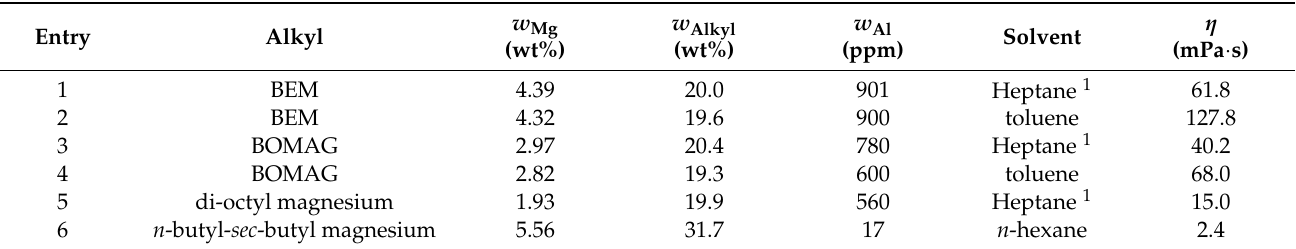
Table 1. Viscosities, aluminum content and concentrations of industrially relevant magnesium alkyls in different